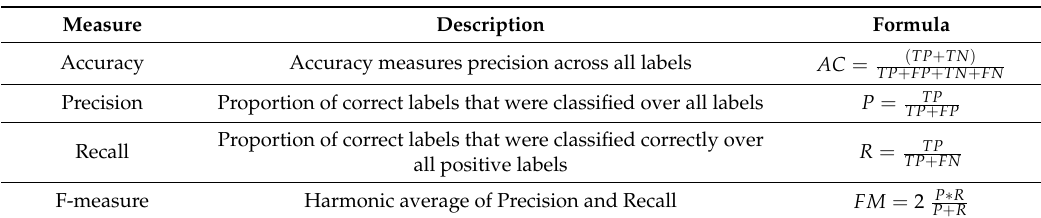
Table 6. Evaluation metrics.